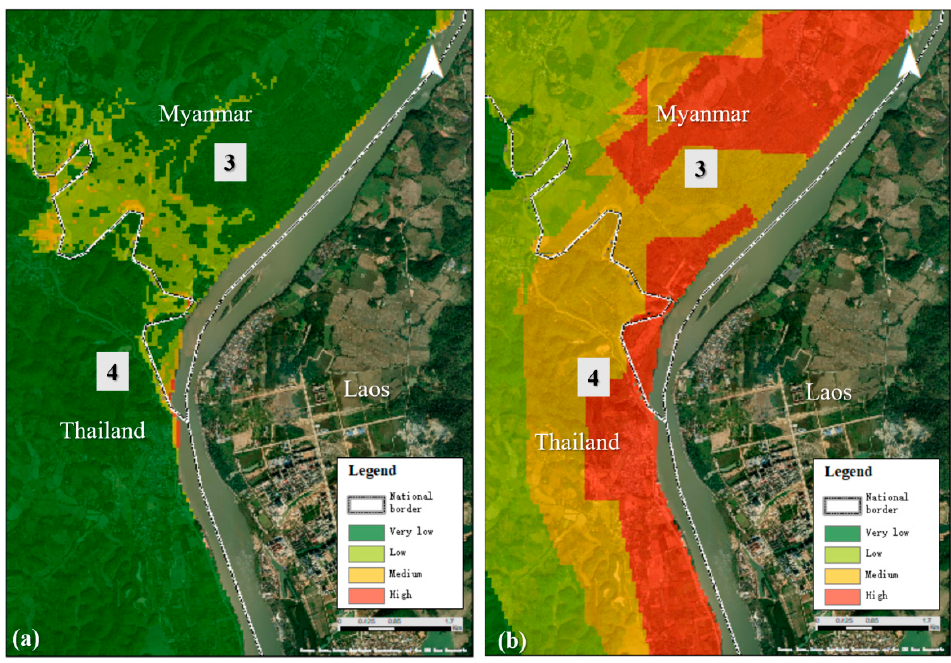
Figure 4. The assessment process for Communities 3 and 4 in Myanmar and Thailand. ( a ) Hazard assessment result; ( b ) vulnerability assessment result. (National border is based on the ESRI ArcGIS Online).